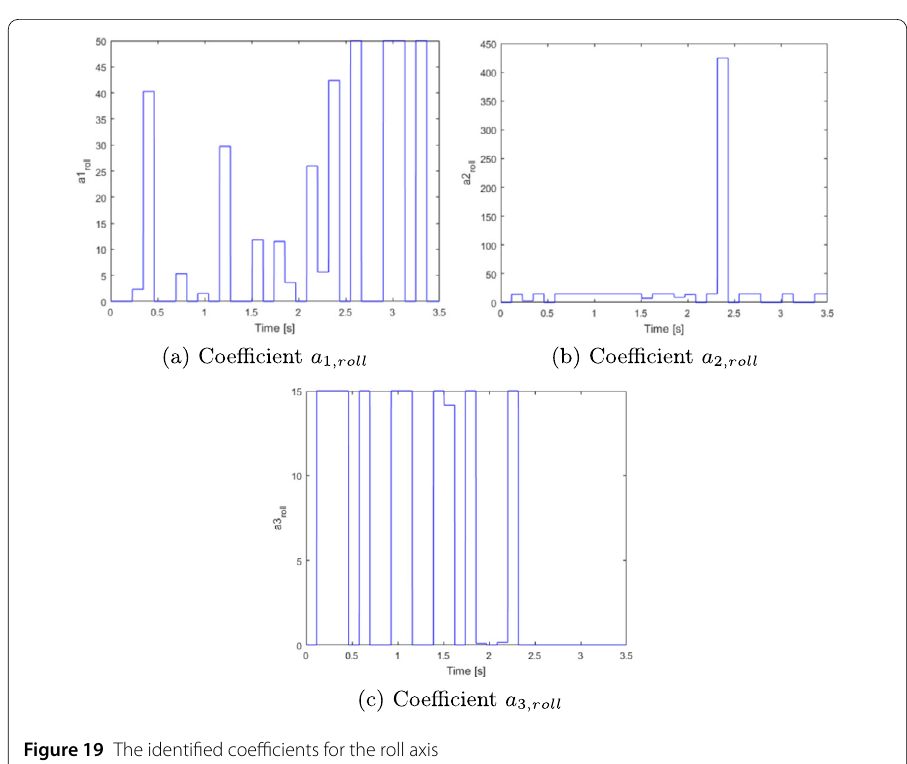
Figure 19 The identified coefficients for the roll axis